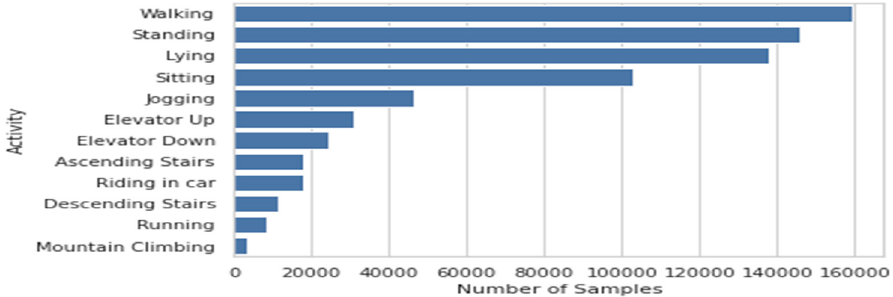
Figure 5. Activity classes by number of samples.